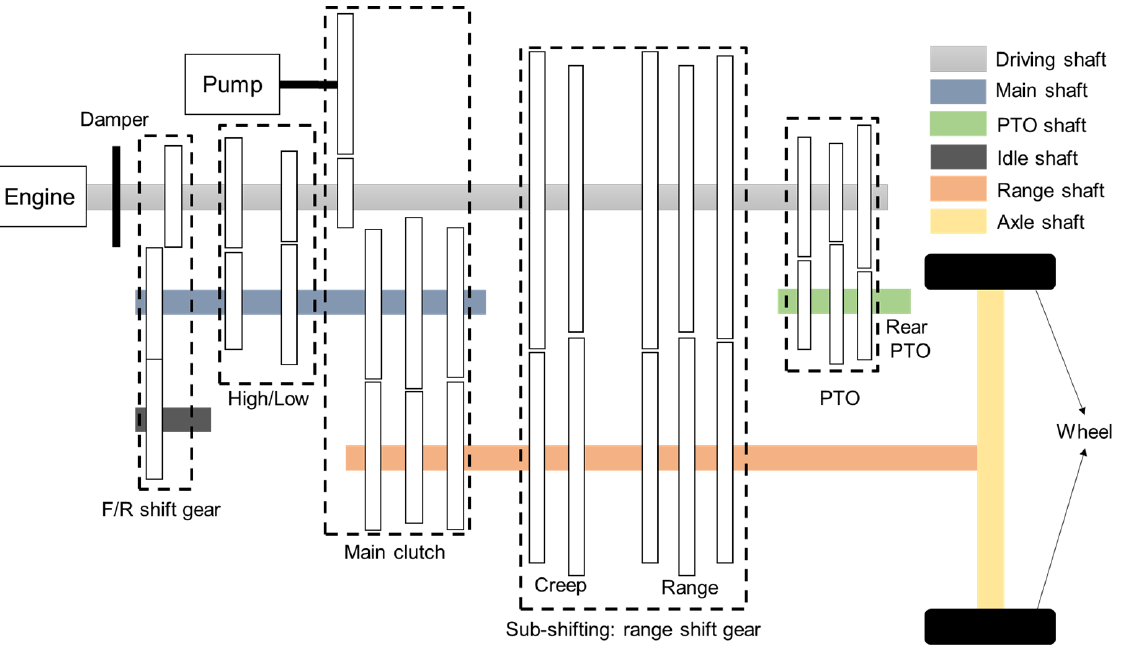
Figure 1. The block diagram of a 95-kW partial PST tractor transmission.